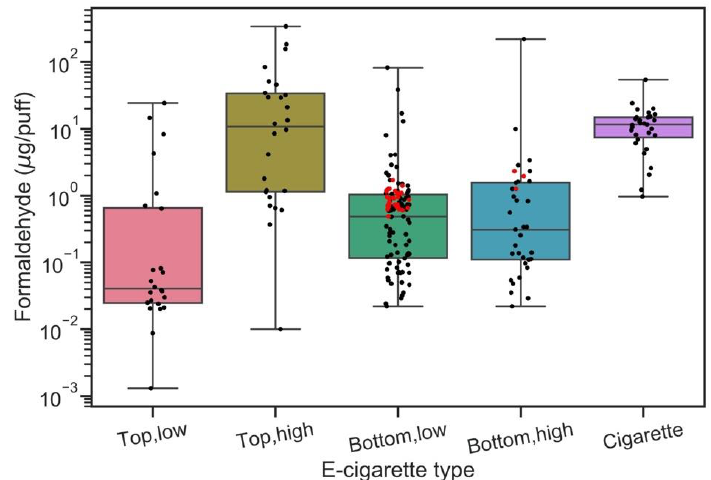
Figure 3. Formaldehyde levels (log-scale) from e-cigarettes with different coil structure (top- and bottom coil) and power outputs (low and high levels determined by lower and higher power outputs [5 watts for top coil and 18 watts for bottom coil] used in the literatures). Red dots indicate our results, and black dots are the results obtained from literatures [4,13–15,19,22,45–49]. Formaldehyde levels in cigarette smoke from literatures [50–52] are shown for comparison purpose.